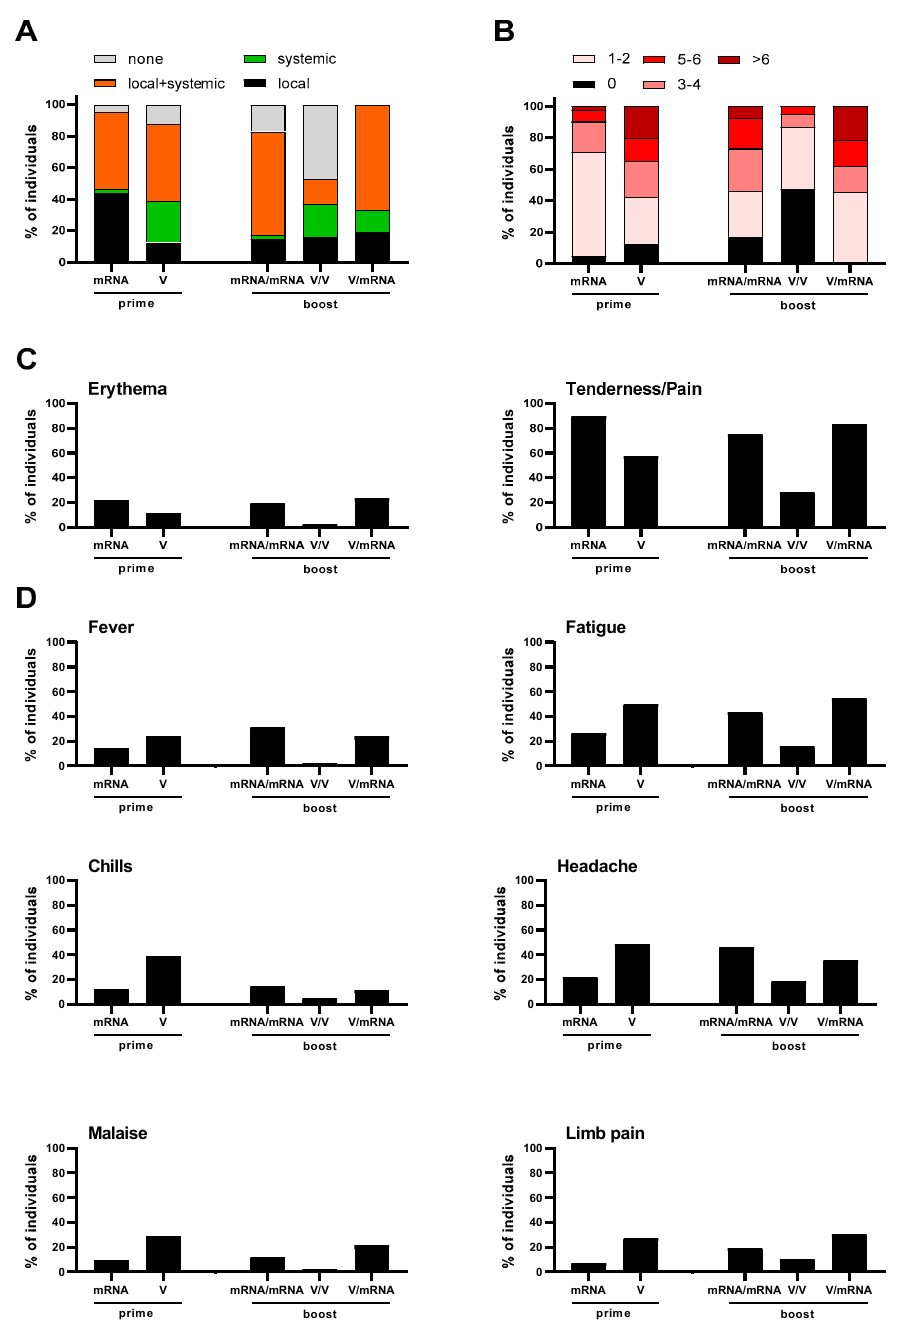
Figure 2. Reactogenicity after prime vaccinations with an mRNA or Vector vaccine and after booster vaccination for the mRNA/mRNA, Vector/Vector (V/V) and Vector/mRNA (V/mRNA) groups. ( A ) Analysis of local and systemic reactions; ( B ) analysis of the severity of reactions based on the number of symptoms; ( C ) analysis of the frequencies of local reactions; ( D ) analysis of the frequencies of systemic